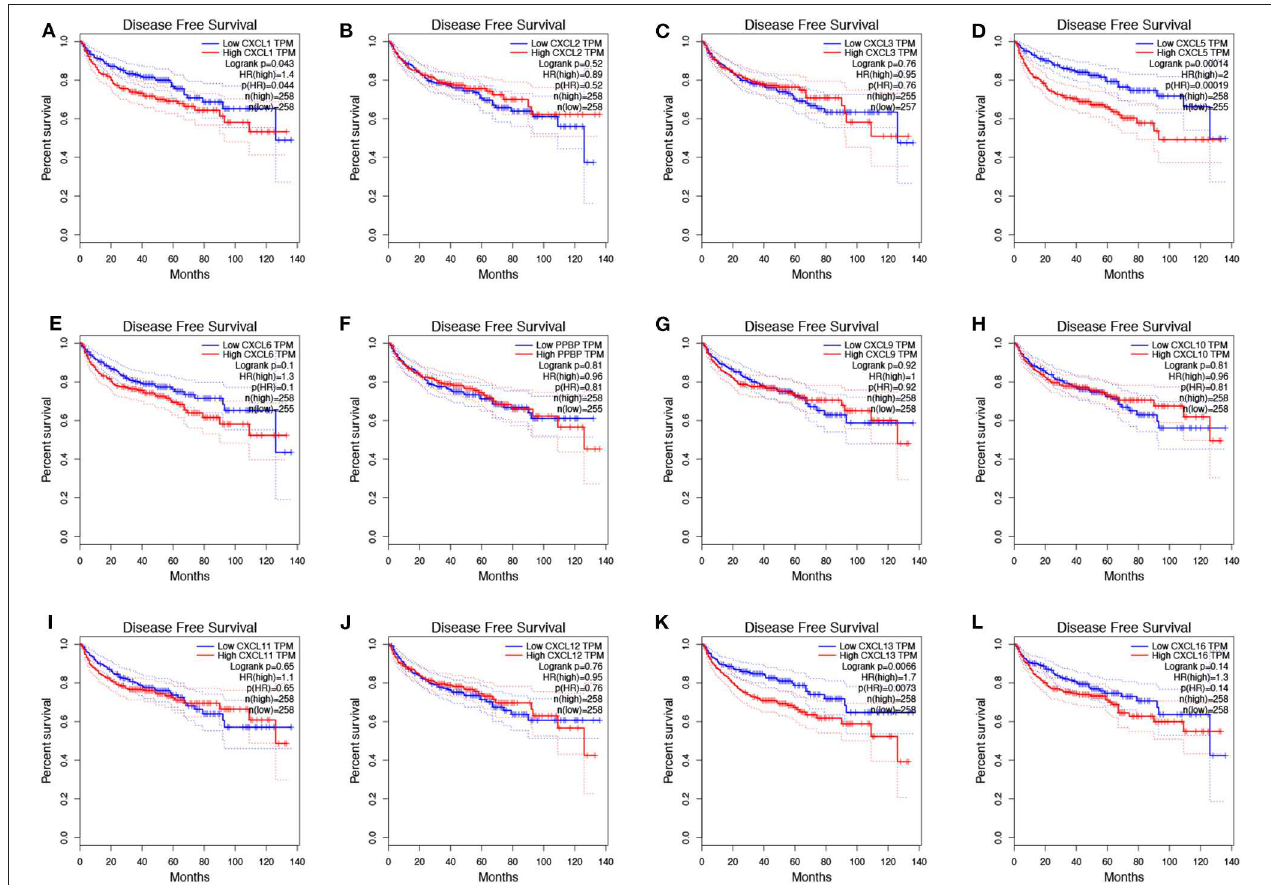
FIGURE 5 | The prognostic value of different expressed CXC chemokines in RCC patients in the disease free survival curve (GEPIA). The disease free survival curve of (A) CXCL1, (B) CXCL2, (C) CXCL3, (D) CXCL5, (E) CXCL6, (F) CXCL7, (G) CXCL9, (H) CXCL10, (I) CXCL11, (J) CXCL12, (K) CXCL13, and (L) CXCL16 in RCC.